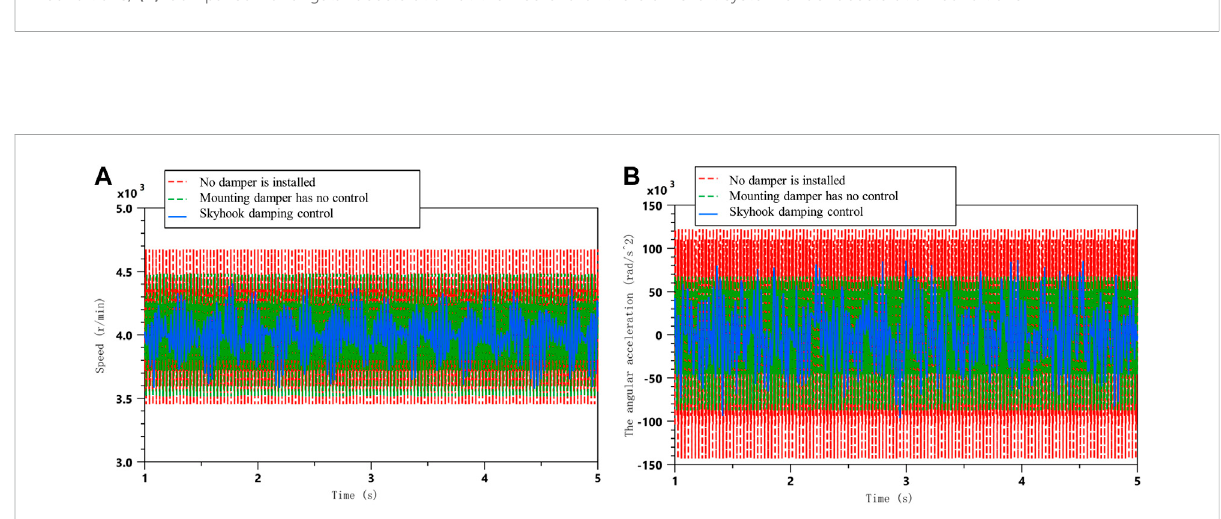
FIGURE 14 Comparison ofsimulationresultsforuniformspeedconditions; (A) Comparisonoffreeendspeedsofcrankshaftsystemsatconstantspeed; (B) Comparison of angular acceleration at the free end of the crankshaft system under uniform speed